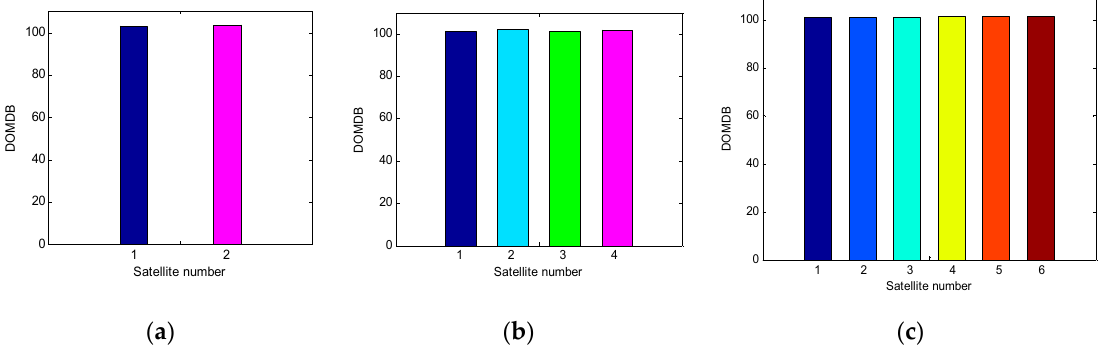
Figure 6. Comparison of each satellite’s DOMDB in the integration with two, four, and six visible satellites, respectively. ( a ) The results under two visible satellites; ( b ) The results under four visible satellites; ( c ) The results under six visible satellites.